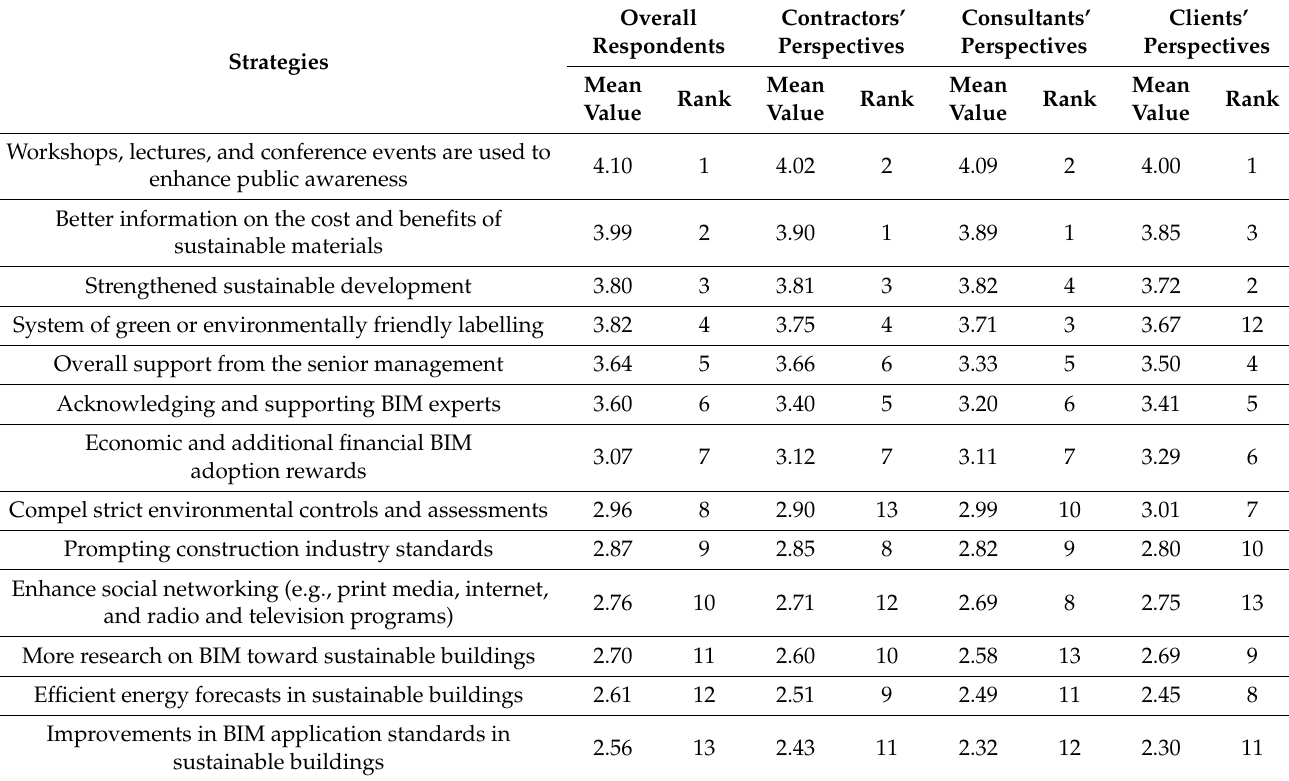
Table 3. Mean score analysis of